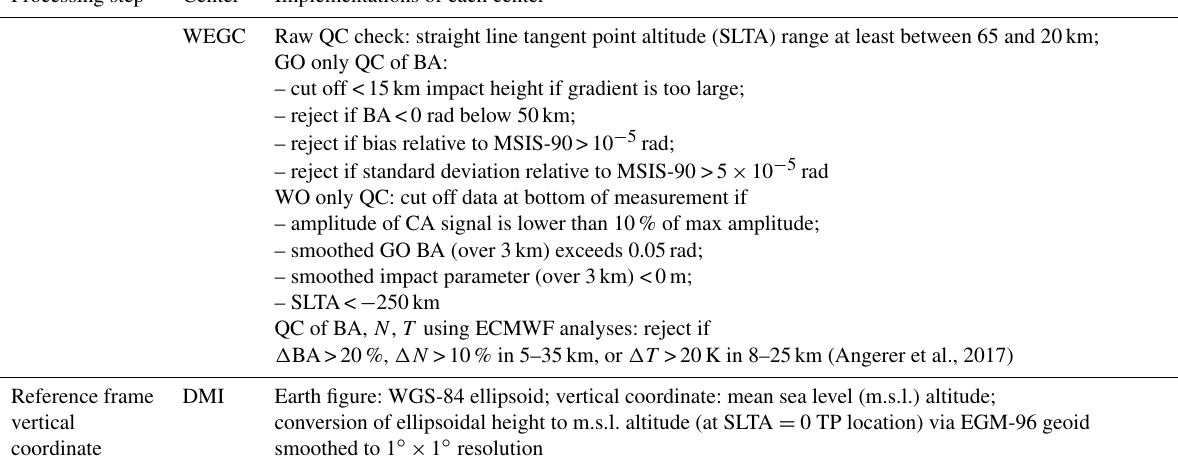
Earth figure: WGS-84 ellipsoid; vertical coordinate: mean sea level (m.s.l.) altitude; conversion of ellipsoidal height to m.s.l. altitude (at SLTA = 0 TP location) via EGM-96 geoid smoothed to 1 ◦ × 1 ◦ resolution GFZ Earth figure: WGS-84 ellipsoid, EGM-96 geoid used for altitude above m.s.l. calculation JPL Earth figure: IERS Standards 1989 ellipsoid; vertical coordinate: m.s.l. altitude computed using the JGM3/OSU91A geoid truncation at spherical harmonic degree 36 UCAR Earth figure: WGS-84 ellipsoid; the occultation point is determined using BA for CIRA + Q climatology (Kirchengast et al., 1999) and 500m observed excess phase; the center of the reference frame is in the local center of curvature of the reference ellipsoid at the occultation point (Syndergaard, 1998) in the direction of the occultation plane; JGM2 geoid undulation is used to calculate m.s.l. altitude WEGC Earth figure: WGS-84 ellipsoid; vertical coordinate: m.s.l. altitude; conversion of ellipsoidal height to m.s.l. altitude (at SLTA = 0 TP location) via EGM96 smoothed to 2 ◦ × 2 ◦